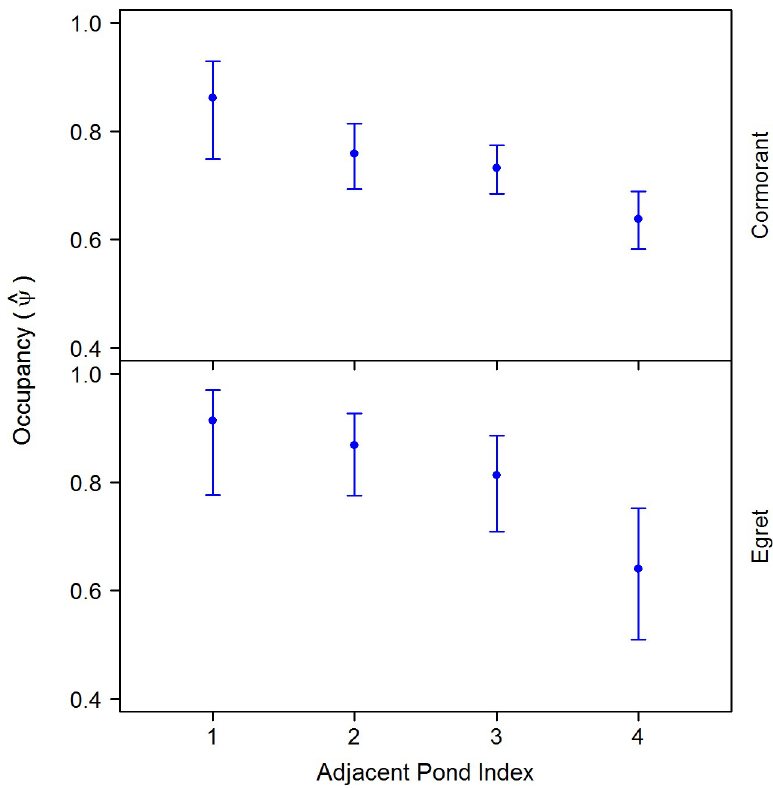
Fig 5. Occupancy probability (+95% CI) of cormorants and egrets on catfish ponds in the Mississippi Delta by adjacent pond index. Estimates were made using the top ranked model for each species, while keeping all other variables at their mean value. This index is based on the general isolation of catfish ponds relative to adjacent ponds (i.e. 1 = a pond with only one other adjacent pond present at any given edge).